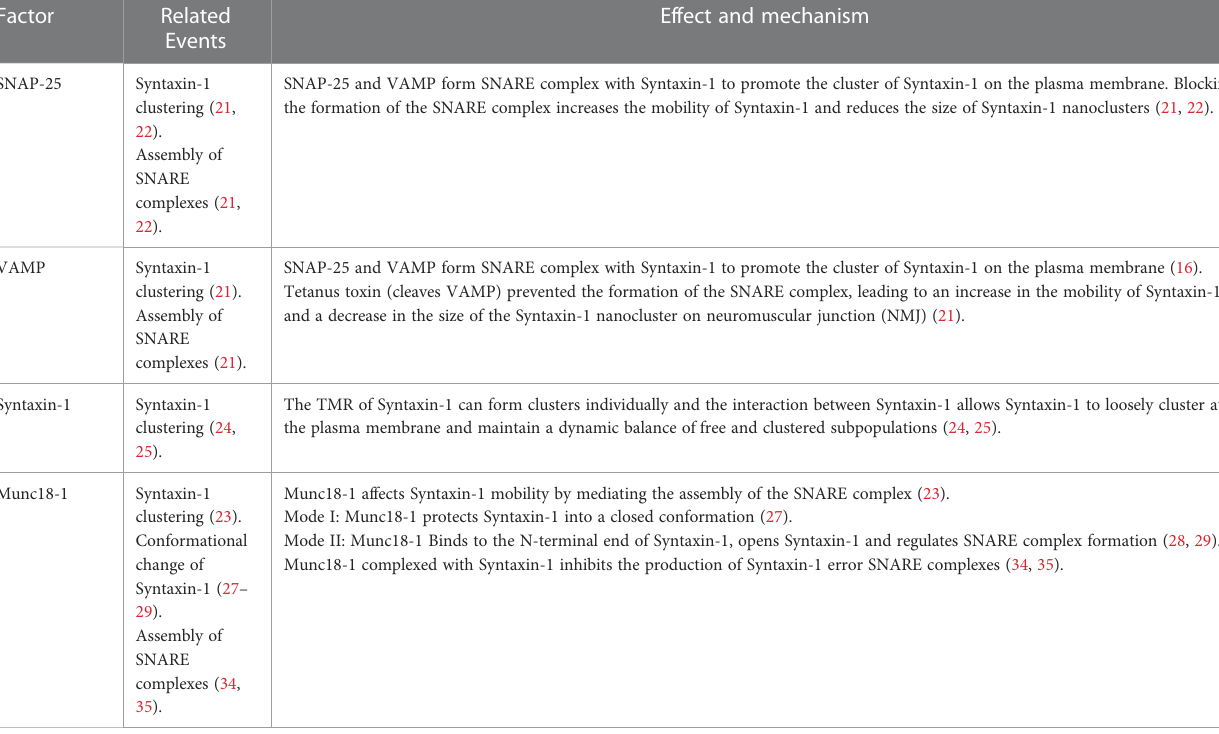
Effect and mechanism